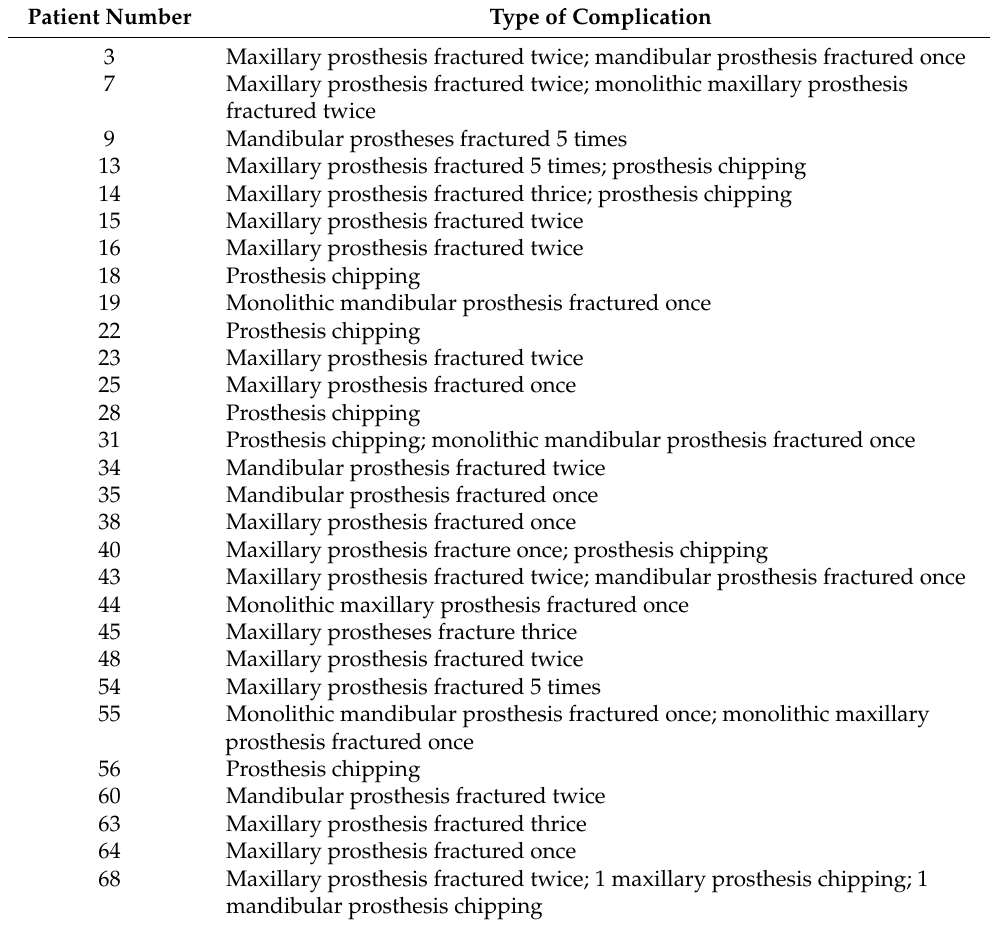
Table 7. Description of prosthetic complications occurred up to seventh year in